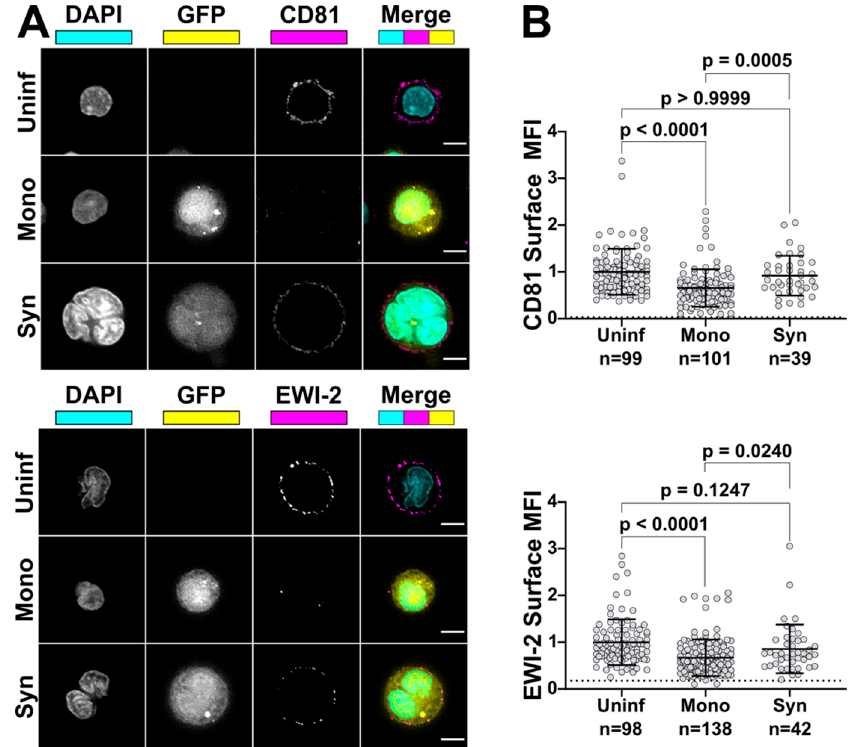
Figure 6. Syncytia have higher surface expression of EWI-2 and CD81 than mononucleated infected cells. ( A ) Primary CD4 + T cells were infected with NL-sfGI, surface-labeled for either EWI-2 or CD81 (both shown in magenta), fixed, stained with DAPI (cyan) and AlexaFluor 647-conjugated secondary antibody, and imaged. Infected cells were identified by GFP (yellow) and discriminated as mono- or multinucleated infected cells by DAPI. Representative cells are shown. Scale bars = 5 µ m. ( B ) Cells were prepared as described in ( A ) and analyzed for EWI-2 or CD81 surface expression on uninfected cells, mononucleated infected cells (Mono) and syncytia (Syn) by manually selecting the plasma membrane at the midline of each cell and quantifying the mean EWI-2 or CD81-associated fluorescence intensity. Raw fluorescence intensity values were background-subtracted using the fluorescence intensity of a cell-free area within the same image and subsequently normalized to the average intensity value of uninfected cells within the same imaging set. Data shown are the pooled normalized intensity values of two independent biological replicates, each with two technical replicates. Each data point represents the normalized surface MFI of an individual cell. Error bars = SD. p -values are the result of two-tailed non-parametric Mann-Whitney U tests.